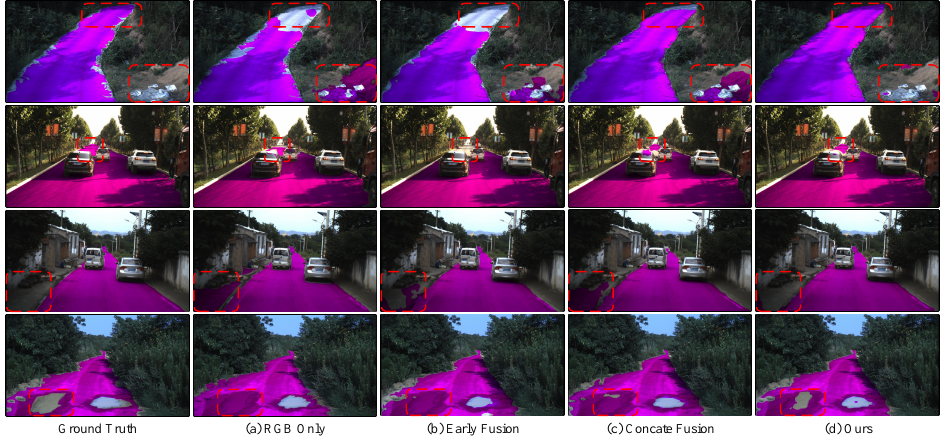
Figure 5. Examples on the HSI road dataset, where ( a – d ) show the segmentation results obtained by single-modal HRNet, early fusion U-Net, concatenate fusion MU-Net, and our proposed MMCAN,